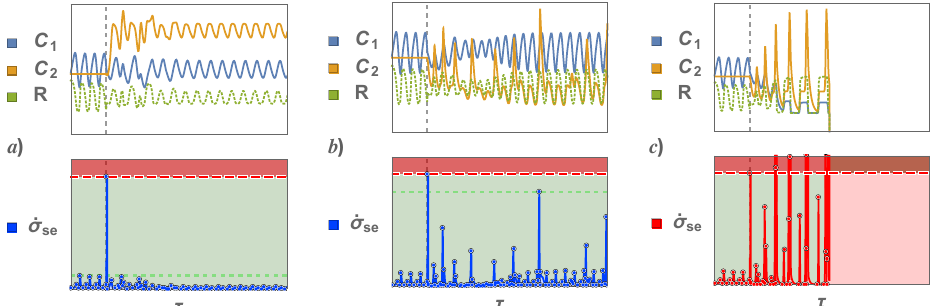
Figure 5. Illustration of the different nature of possible solutions in terms of the populations dynamics (upper panels) and the corresponding social-ecological entropy production (lower panels) of the D-P mode of knowledge-transfer method. ( a ) Sustainable: The post-intervention dynamics has low entropy production rate after the intervention by the second community making this scenario a very resilient one. ( b ) Sustainable: The post-intervention dynamics is still sustainable but it has a higher entropy production rate. Therefore, it is less resilient after the intervention by the second community than in case ( a ). ( c ) Unsustainable dynamics with catastrophic fate. After few oscillations after the intervention the dynamics collapses, surpassing the entropy production rate threshold. See the main text for a detailed discussion of the results. The figure is the authors’ own